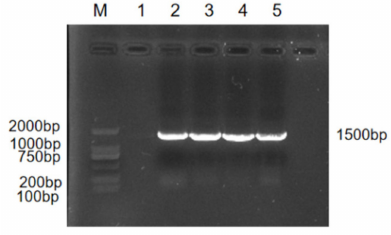
Figure 3. Agarose gel electrophoresis (cropped).